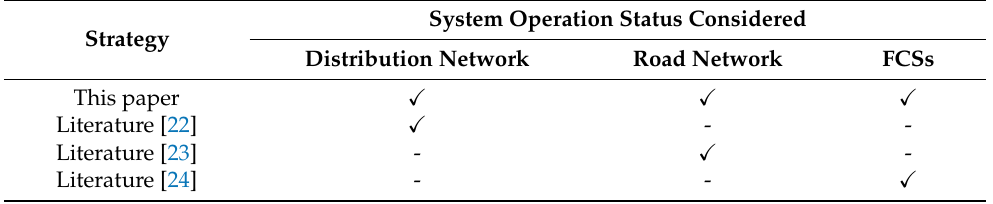
Table 1. Comparison of guidance strategies.